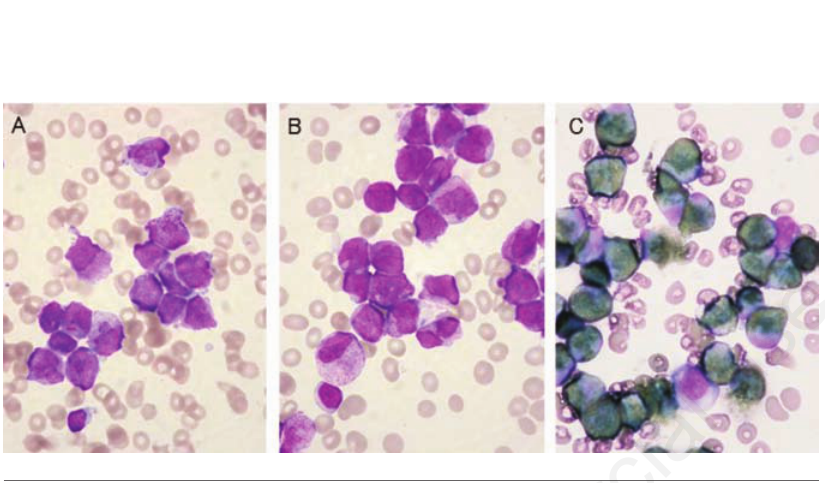
Figure 2. Typical acute promyelocytic leukemia (APL) cells in bone marrow. A) and B) APL cells with hypergranular cytoplasm and Auer body or faggot cells (May-Giemsa staining); C) strongly positive staining for peroxidase.